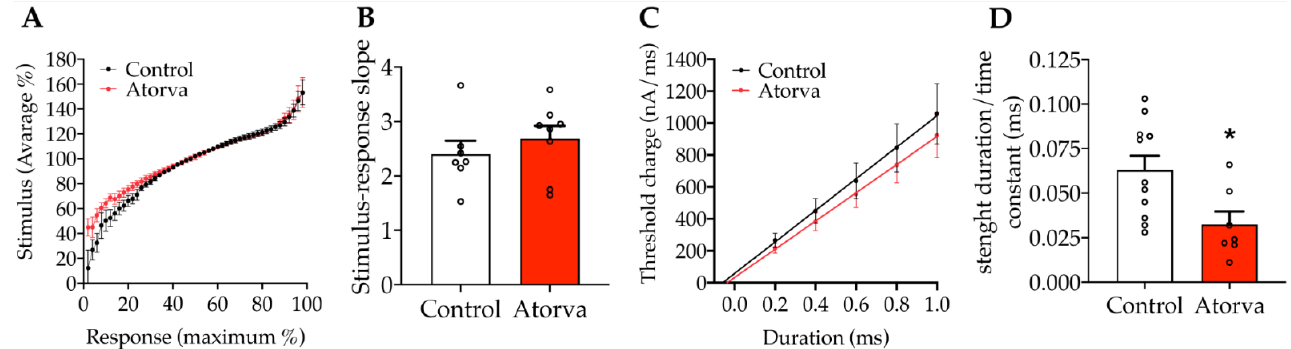
Figure 8. Stimulus-response protocol recordings are presented as the relationship between the % of supramaximal CAP response evoked by crescent current stimuli, normalized on the complex average stimulus applied. Plotted representation of stimulus-response curves ( A ). This parameter was statistically analysed comparing stimulus-response slope values ( B ); Control n = 7, Atorva n = 8; unpaired t -test n.s. p = 0.4205, t = 0.8318, df = 13). Threshold modulation mediated by different charge duration (from 0.2 ms to 1.0 ms square pulse) is presented as raw threshold measurement ( C ). The comparison between experimental conditions was performed on time constant values ( D ); control n = 11, atorva n = 7; unpaired t -test * p = 0.0189, t = 2.610, df = 16. n = 9. Control = high-fat high-cholesterol diet; Atorva = high-fat high-cholesterol diet plus atorvastatin.